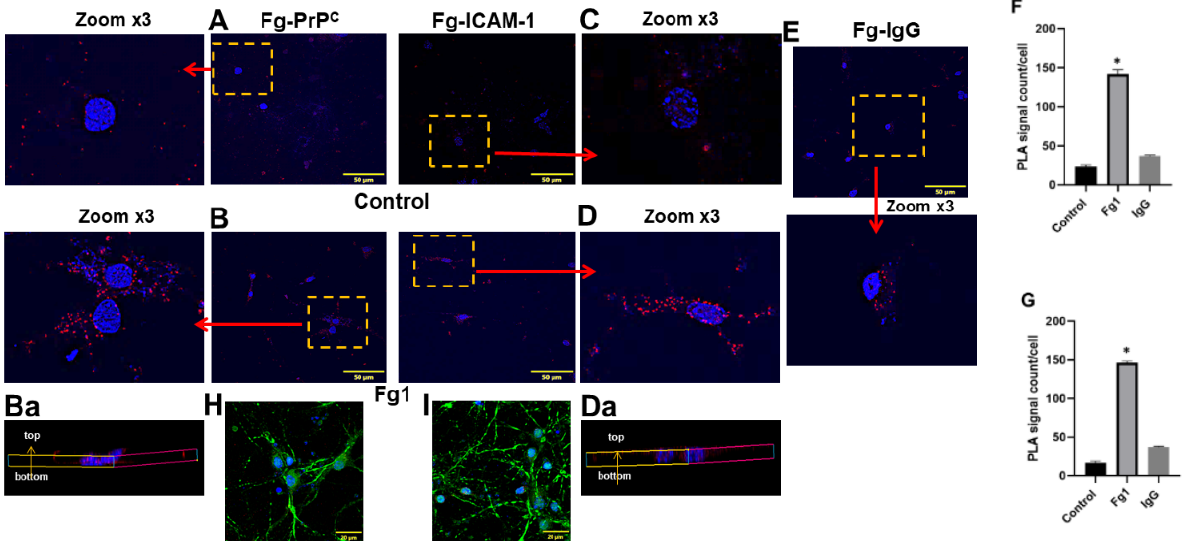
Figure 2. Interactions of fibrinogen (Fg) with its receptors, cellular prion protein (PrP C ) and intercellular adhesion molecule-1 (ICAM-1) on the surface of neurons detected by proximity ligation assay (PLA). Representative images of PLA signals shown as red dots indicating interactions between ( A , B ) Fg and PrP C (Fg-PrP C ) and ( C , D ) between Fg and ICAM-1 (Fg-ICAM-1). Neurons were treated with medium alone (control) ( A , C ) or with 1 mg/mL of Fg (Fg1) for 24 h ( B , D ). Fg, PrP C and ICAM-1 were detected using anti-Fg, anti-PrP C , and anti-ICAM-1 antibodies, respectively. Enlarged (3 × zoom) images (shown in yellow punctuated boxes) are pointed to by red arrows. Standardized size images of each selected area of interest were collected by acquiring at least 4 focal planes with increments of 0.5 μ m to form a final z-stock image. Representative three-dimensional reconstructions of the PLA signals (Fg-PrP C and Fg-ICAM-1) on the surface of neurons from the respective z-stack images (Ba,Da). ( E ) One group of neurons treated with 1 mg/mL of Fg were probed with Immunoglobulin G (IgG) (Fg-IgG) and used as a negative control to define the specificity of the PrP C and ICAM-1 detecting antibodies. Cellular nuclei were labeled with 4 ′ ,6-diamidino-2-phenylindole shown in blue in all images. ( F , G ) Summary of data analysis of interaction of Fg with PrP C and ICAM-1, respectively. The number of PLA signals per cell was quantified into 7 randomly selected similar size areas of interest in each image and averaged for each treatment group. ( H,I ) Neurons were treated similar to B , D using PLA to detect an interaction of Fg with PrP C ( H ) and with ICAM-1 ( I ) with the addition of receiving counterstaining with microtubule-associated protein 2 (green) as a neuronal marker. Cellular nuclei were labeled with 4 ′ ,6-diamidino-2-phenylindole (blue). Hirudin was present in all experimental groups to prevent the conver- sion of Fg to fibrin. p < 0.05 in all; ∗ —vs. Control; n = 4. 3.3. Fg-Induced Upregulation of IL-6 in Neurons Fg dose-dependently upregulated the gene expression of IL-6 (Figure 3A). To further characterize this effect, we tested the level of IL-6 protein present in the media taken from the Fg-treated neurons using an ELISA. Analysis at the mRNA level directly correlated with the results obtained from the measurements of IL-6 protein levels (Figure 3B). Fg- induced an increase in the expression of the IL-6 gene. IL-6 protein expression was re- duced with the use of blocking peptide against PrP C or function-blocking antibody against ICAM-1 (Figures 3A,B, respectively).